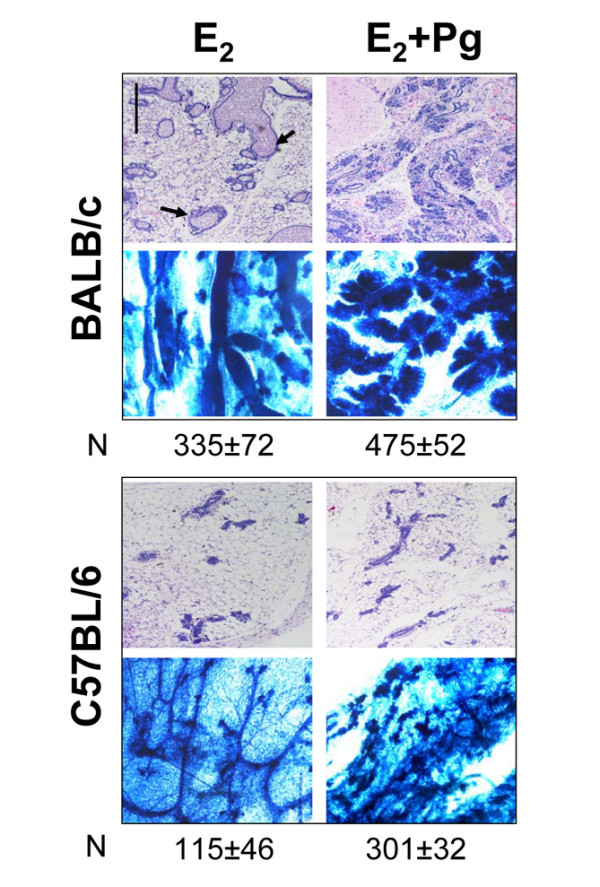
Mammary glands from BALB/c or C57BL/6 mice treated with E2 or E2 plus Pg. Mice were implanted subcutaneously with silastic pellets containing E2 (20 μg) or Pg (20 mg) + E2 (20 μg). Representative H&E stained sections and WM are shown. The arrow points to ductal dilatations, typical of E2 action in BALB/c mice. All WM pictures were taken at the same magnification. Magnification: 100×, bar: 1.1 μm.P < 0.05, BALB/c versus C57BL/6. E2, 17β-estradiol; H&E, hematoxylin and eosin; N, number of structures/slide; Pg, progesterone; WM, whole mount.